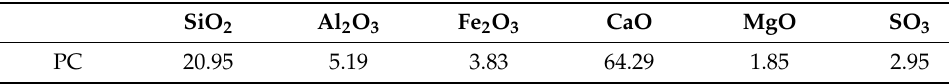
Table 1. Chemical composition of cement (w/%).